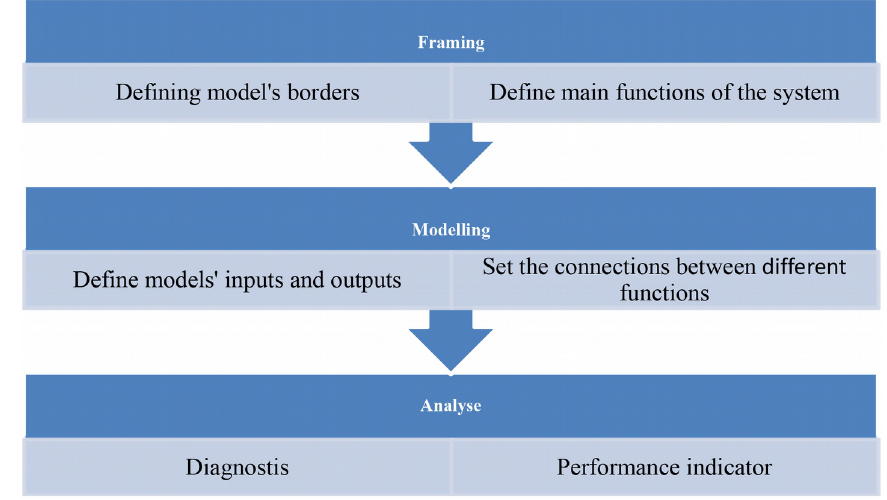
Figure 1. Modeling